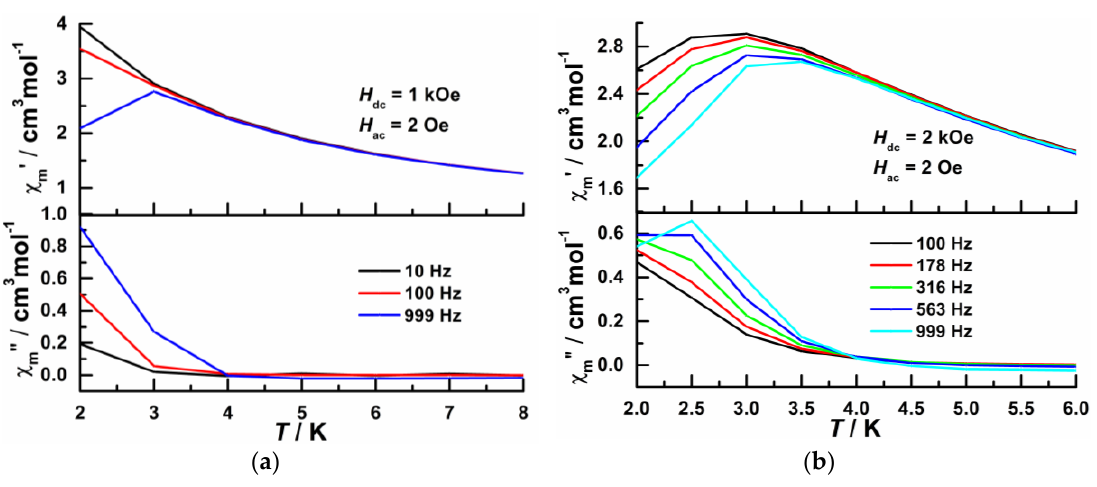
Figure 4. Temperature dependence of the in-phase ( χ ′) and out-of-phase ( χ ″) ac susceptibilities ( a ) for 2 under a 1 kOe and ( b ) for 3 under a 2 kOe dc field.